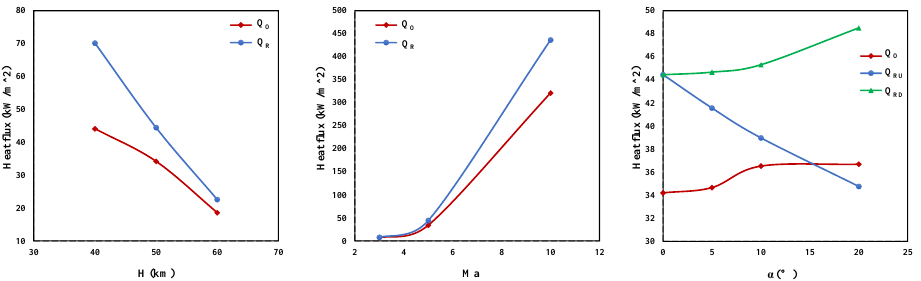
Figure 21. Influence law of flight parameters on surface heat flux.